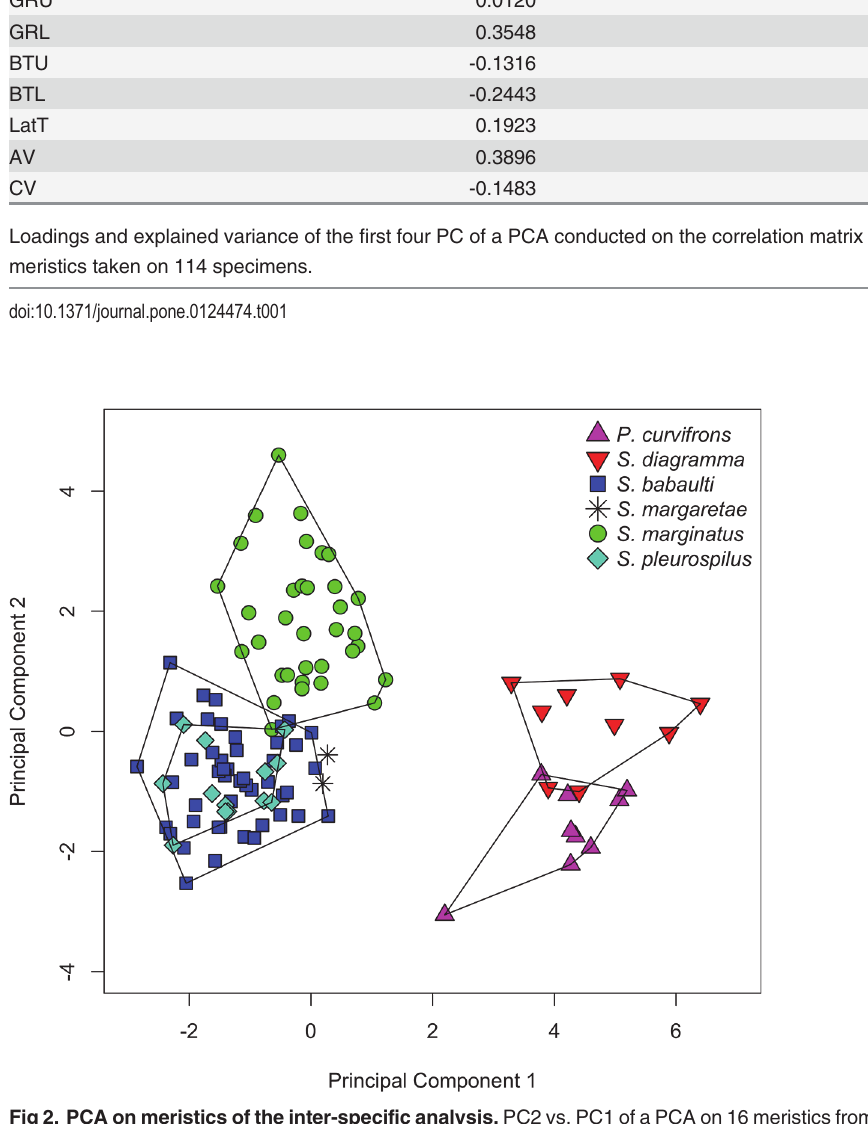
Fig 2. PCA on meristics of the inter-specific analysis. PC2 vs. PC1 of a PCA on 16 meristics from 114 specimens belonging to the six Simochromis and Pseudosimochromis